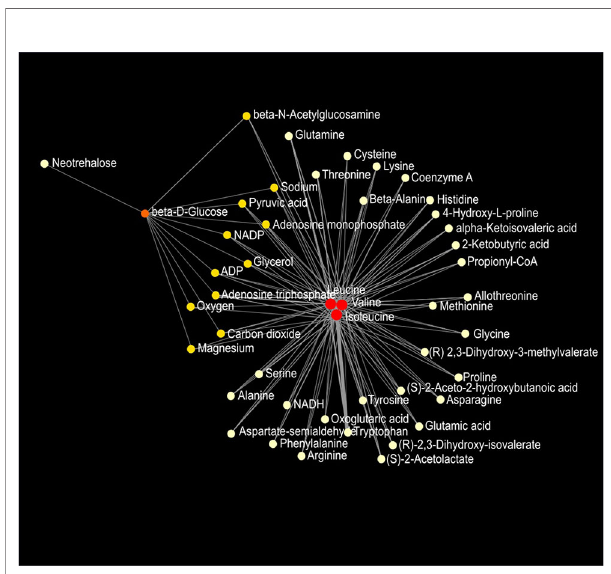
FIGURE 9 | Metabolic network of plasma metabolites between wild-type and Mcp-1 -/- mice fed the high-fat diet. Colors, from white-yellow to red, indicate levels of impact the metabolites have to the network in an ascending order (the number of connections a node has to other nodes and the number of shortest paths going through the node). Network statistics are presented in Supplementary Table 3